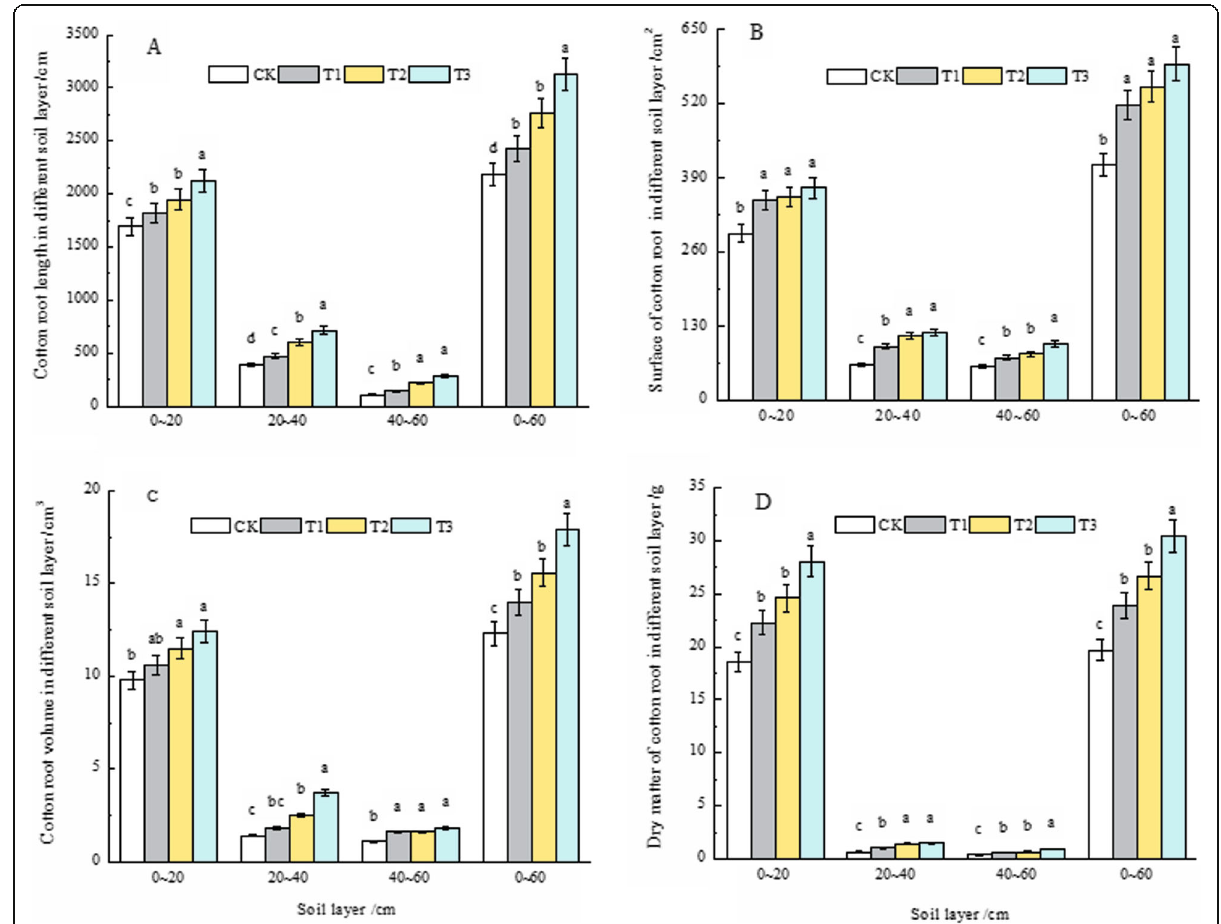
Fig. 9 Changes in cotton root characteristics in different soil layers in different treatments in 2015